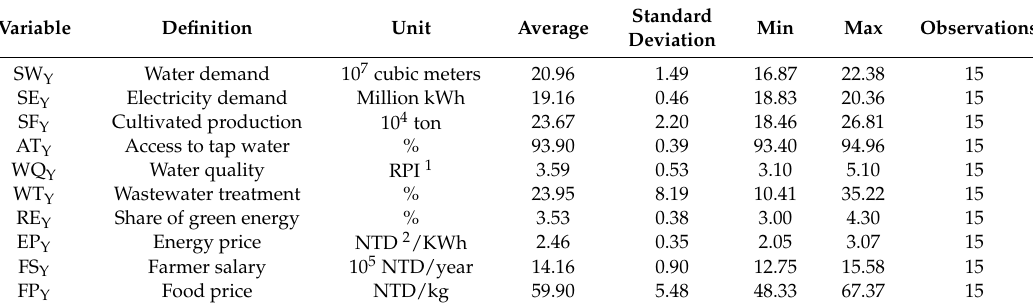
Table 1. Descriptive statistics of each variable in the rural model (Yunlin area).